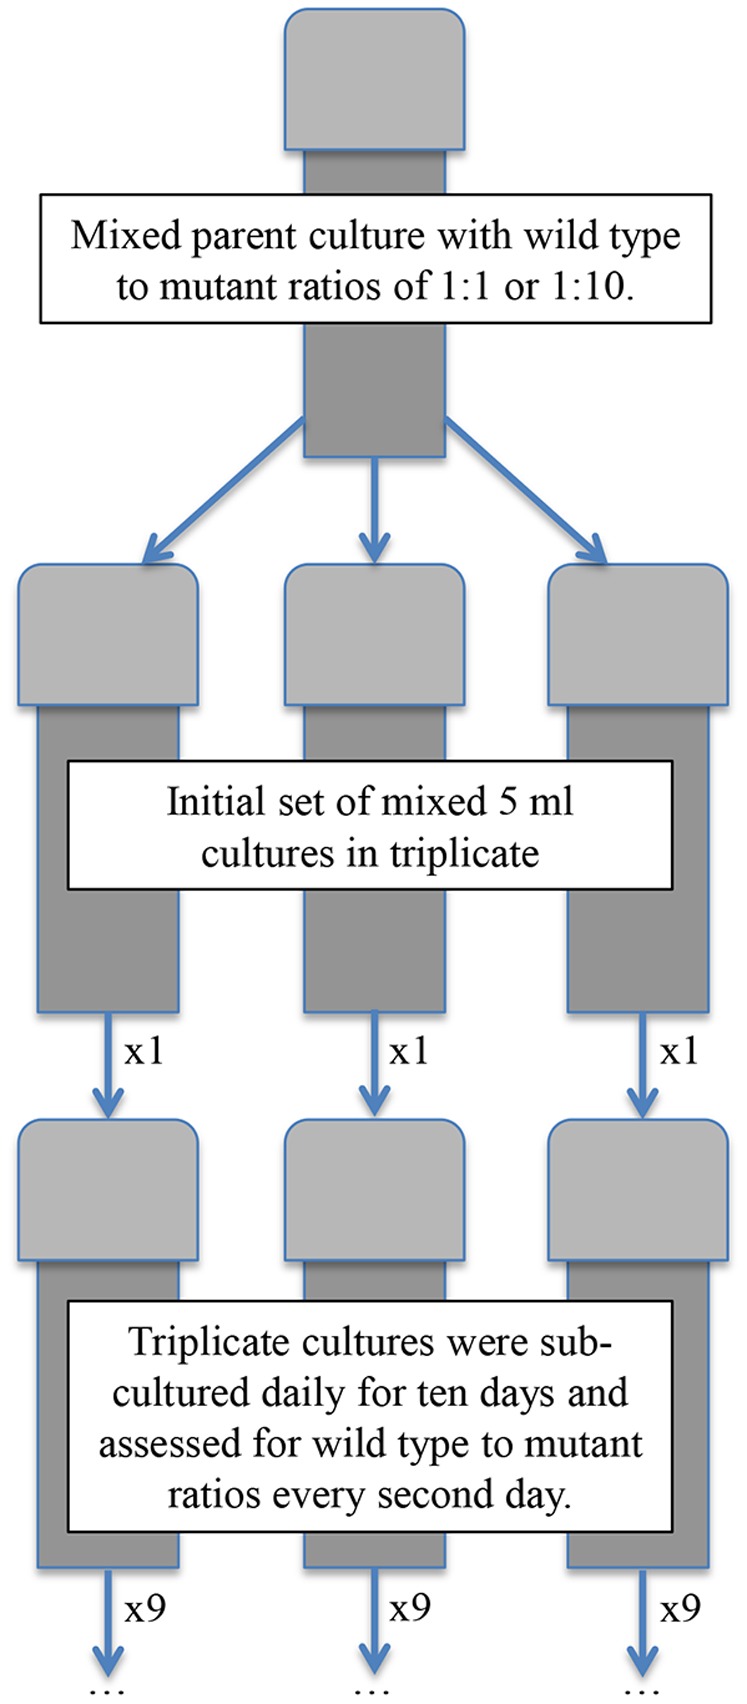
Experimental design for competition experiments.Mixtures of Vibrio fischeri wild type (MJ1) and luxI mutant (MJ211) strains at optical density based starting ratios of 1∶1 or 1∶10 were inoculated (100 µl) into 5 ml of fresh media in triplicate. Each replicate culture was subsequently subcultured daily for ten days and wild type to mutant ratios determined every second day.